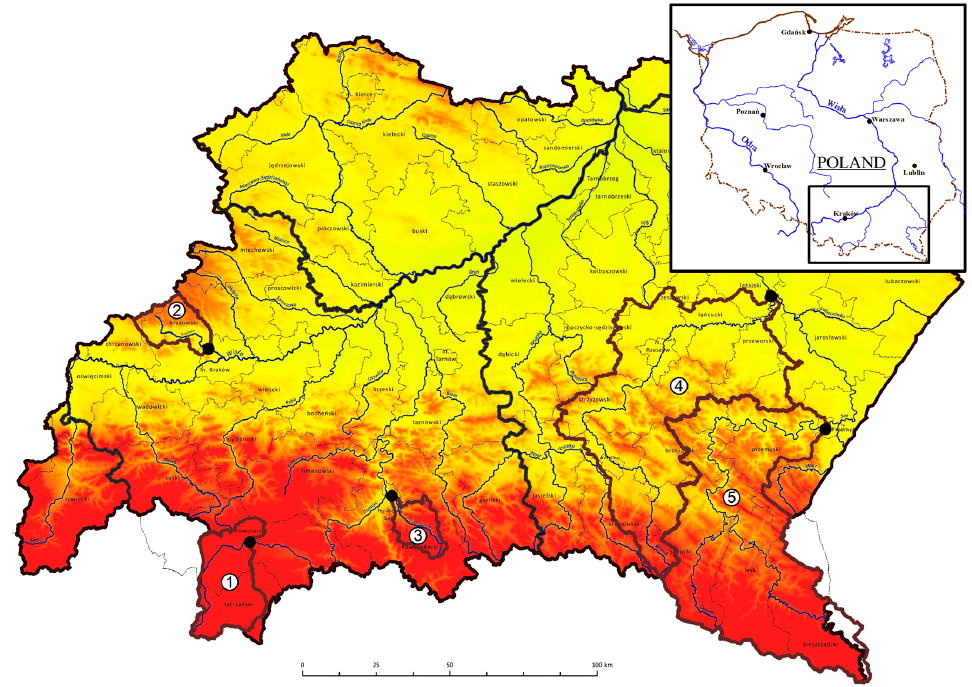
Figure 1. Location of the analyzed river catchments against the upper Vistula basin: (1) the